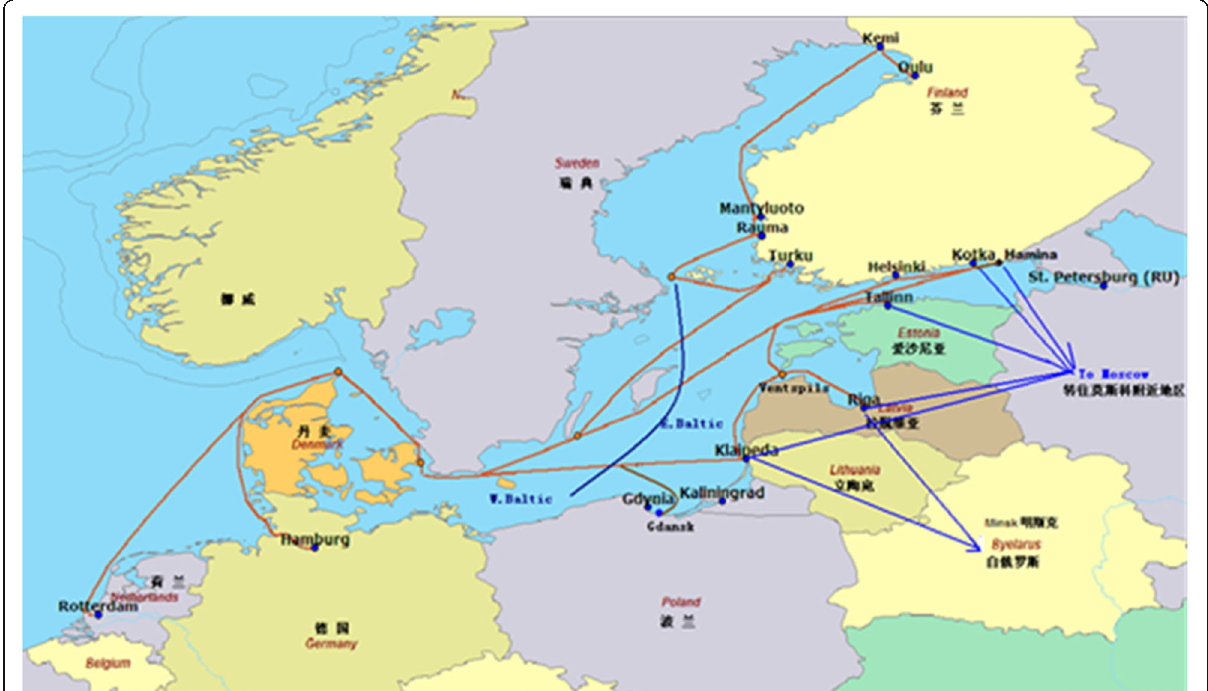
Fig. 1 Main service route for the Baltic Sea Ports